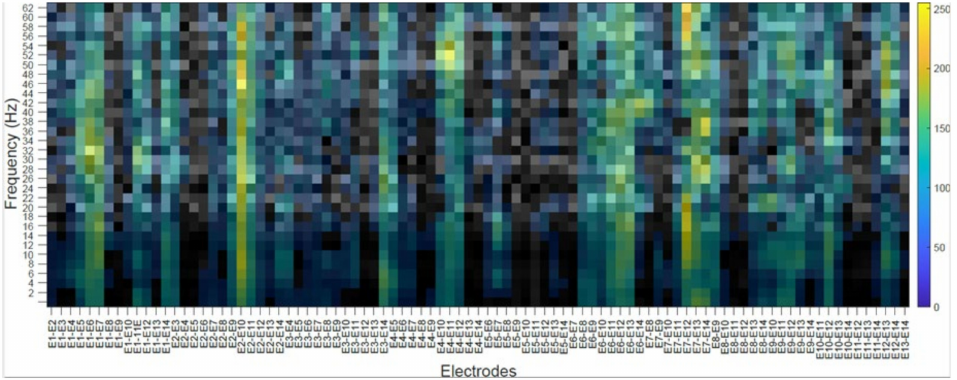
Figure 11. Subject’s internal representation (CAM) in imagined tasks of the vowel /o/. The horizontal axis represents the difference between electrodes and the vertical axis, the corresponding frequencies.